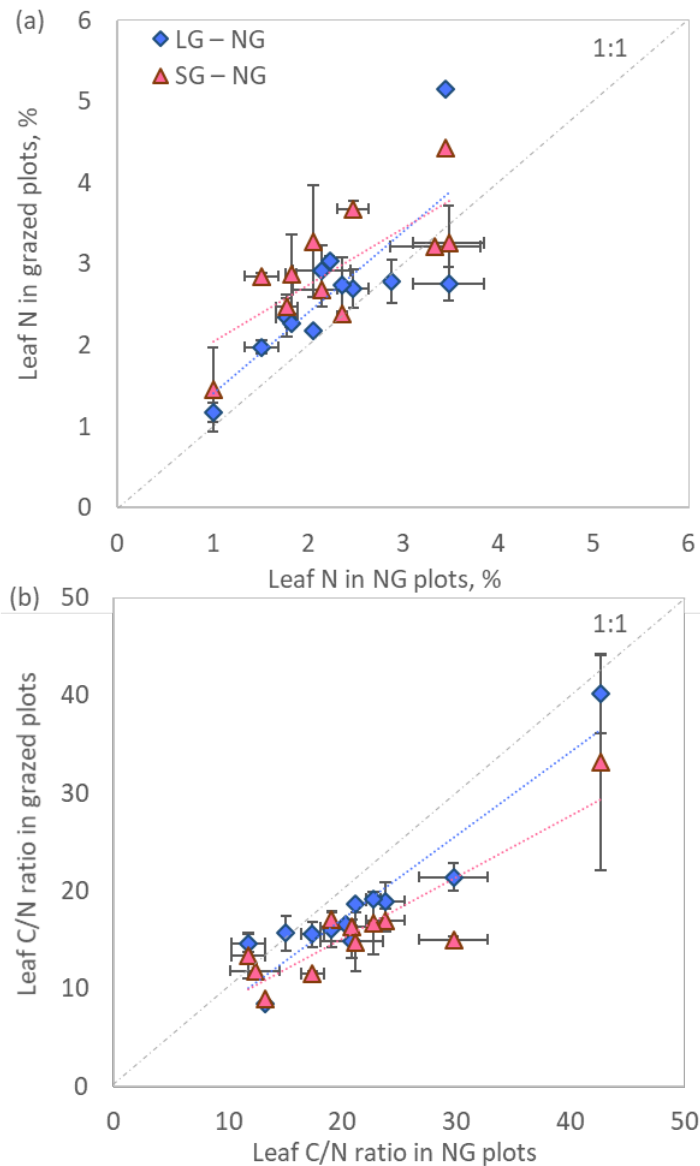
Figure 2. ( a ) Leaf N concentration and ( b ) leaf C/N ratio of individual species in grazed versus non Figure 2. ( A ) Leaf N concentration and ( B ) leaf C/N ratio of individual species in grazed versus non grazed plots (mean ± standard error). grazed plots (mean ± standard Table 2. Concentration of N, C/N ratio, isotopic composition of N (δ 15 N veg ) and C (δ 13 C veg ) of green tissues, aboveground biomass and N stock in 5 selected plant species (average ± standard error).